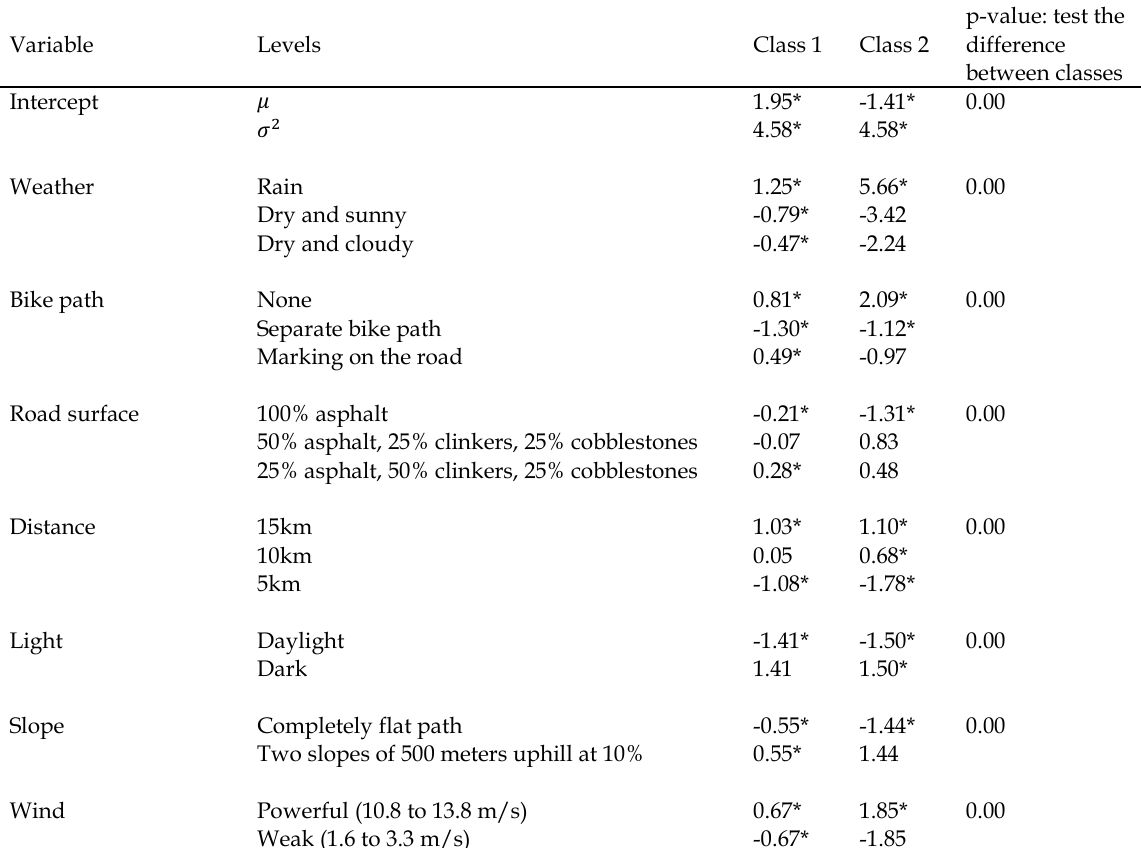
Table 5. Estimation results for the ANA